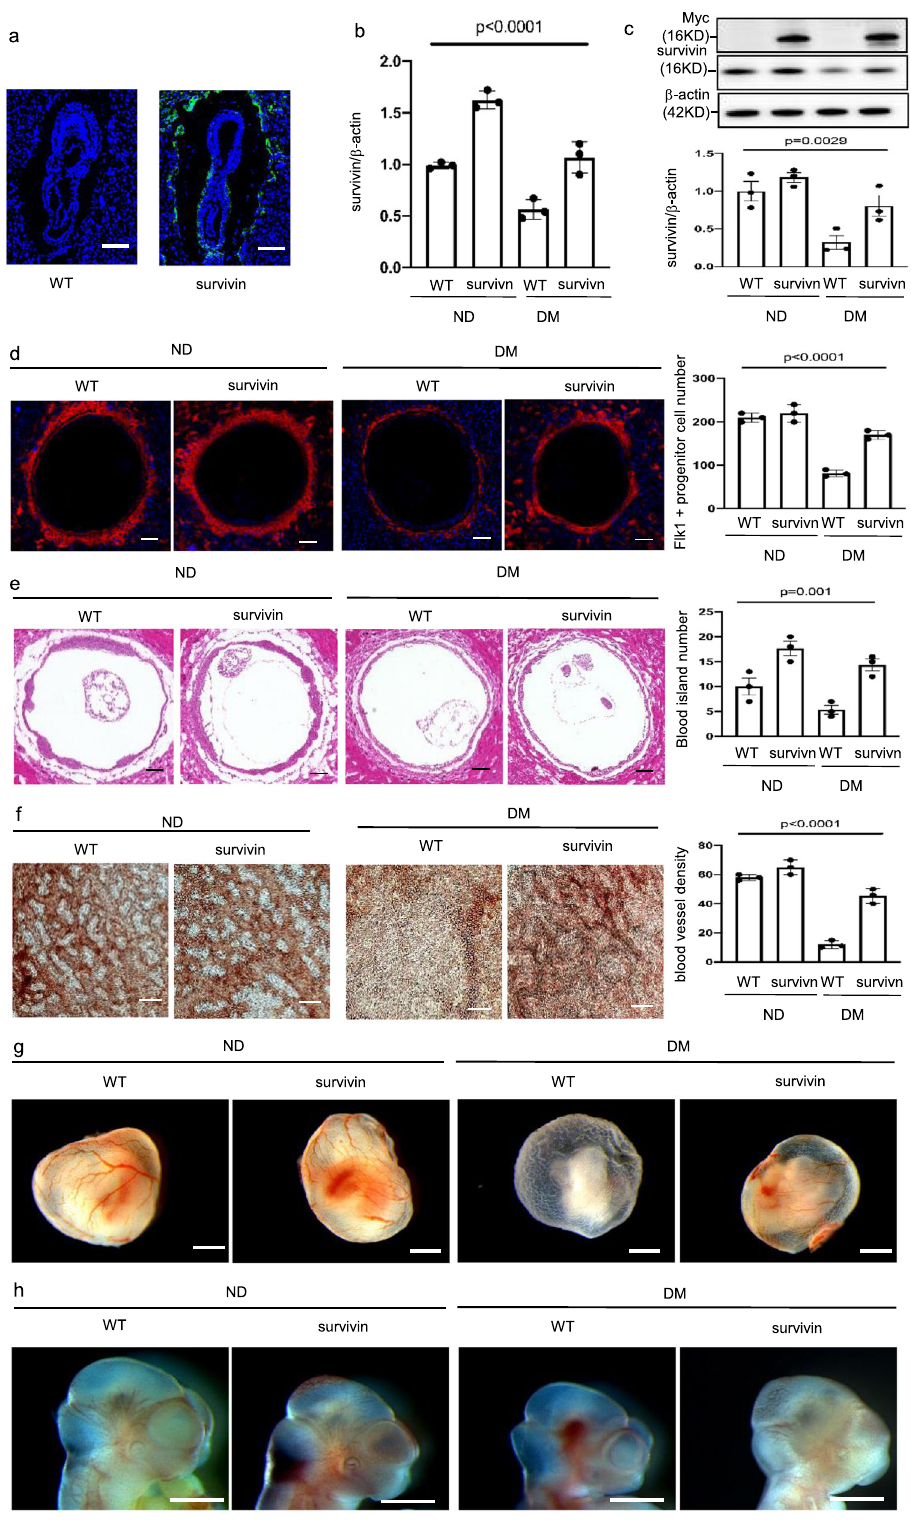
Fig. 5 Survivin overexpression ameliorates maternal diabetes-induced vasculopathy. a GFP was robustly expressed in Flk-1 + progenitors in the yolk sacs of E8.5 conceptuses. Bars = 200 μ m. Survivin mRNA ( b ) and protein ( c ) expression in E8.5 embryos. d Imaging and quanti fi cation of Flk-1 + progenitors in the yolk sacs of E8.5 conceptuses. Cell nuclei were stained with DAPI (blue). Bars = 100 μ m. e Imaging and quanti fi cation of blood island numbers in the yolk sacs of E8.5 conceptuses (HE staining). Bars = 100 μ m. f Blood vessel density determined by CD31 staining in the yolk sacs of E8.5 conceptuses. Bars = 25 μ m. g View of blood vessels in the yolk sacs of E8.5 conceptuses. Bars = 100 μ m. h CD31 staining in E8.5 embryos showing disruptive blood vessel formation in embryos exposed to maternal diabetes. Bars = 125 μ m. Experiments were performed using three embryos from three different dam per group ( n = 3). * indicates signi fi cant difference compared to other groups ( P <0.05). ND nondiabetic, DM diabetes mellitus, WT wild type, Survivin Survivin transgenic